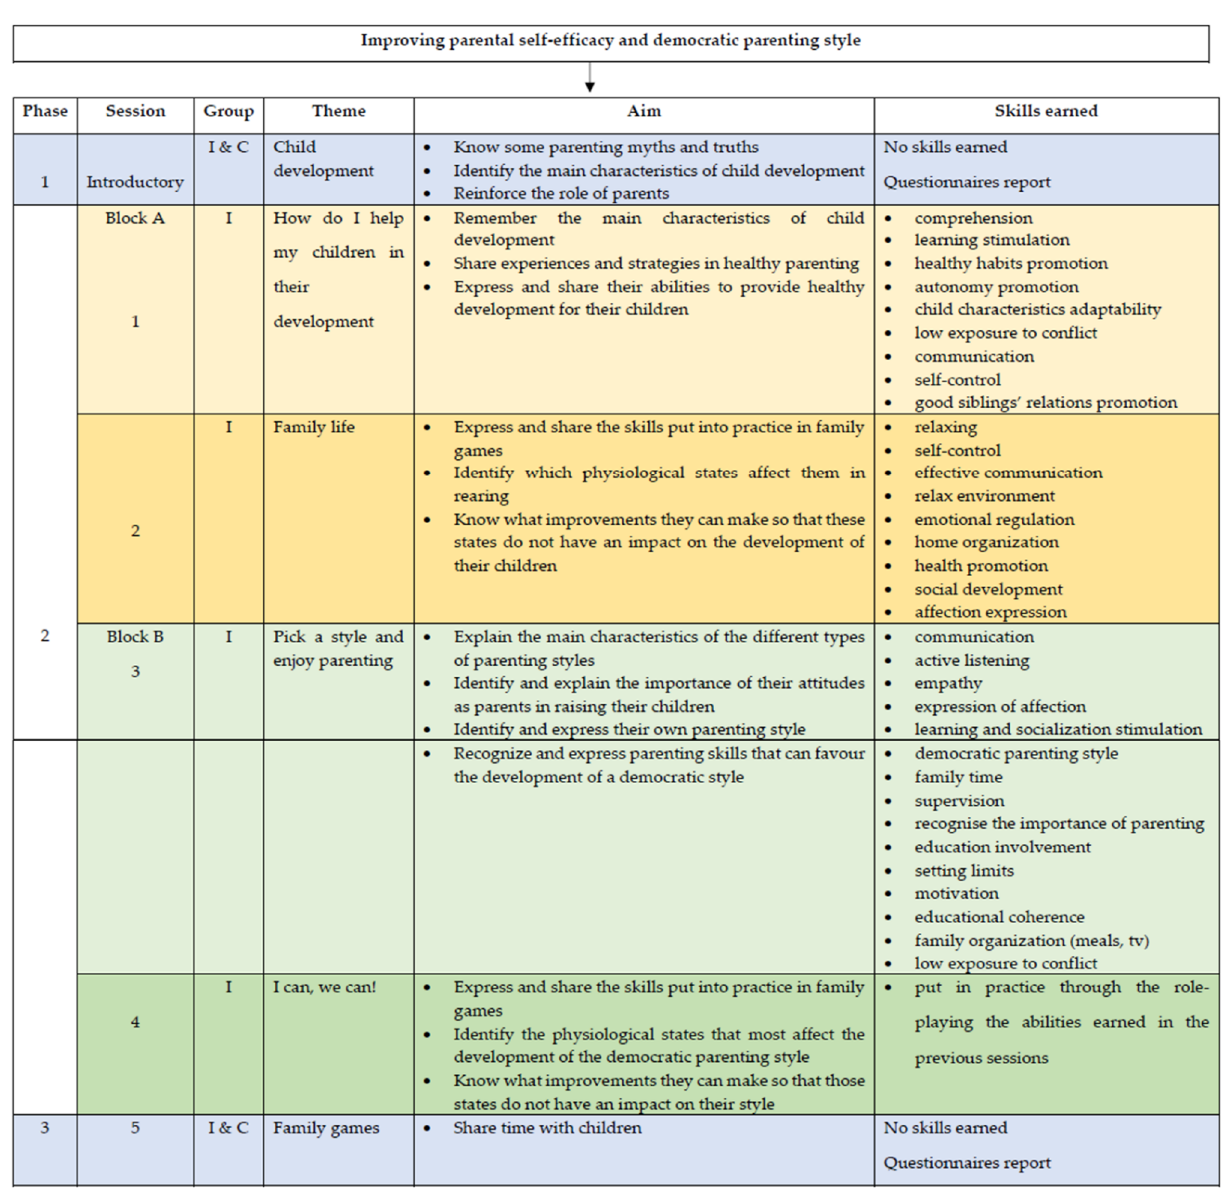
Figure 2. Description of the intervention structure, sessions and skills earned by